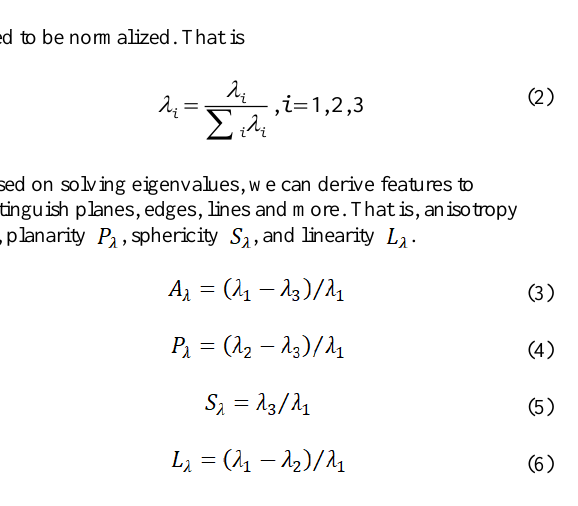
Figure 2. The flow chart of this